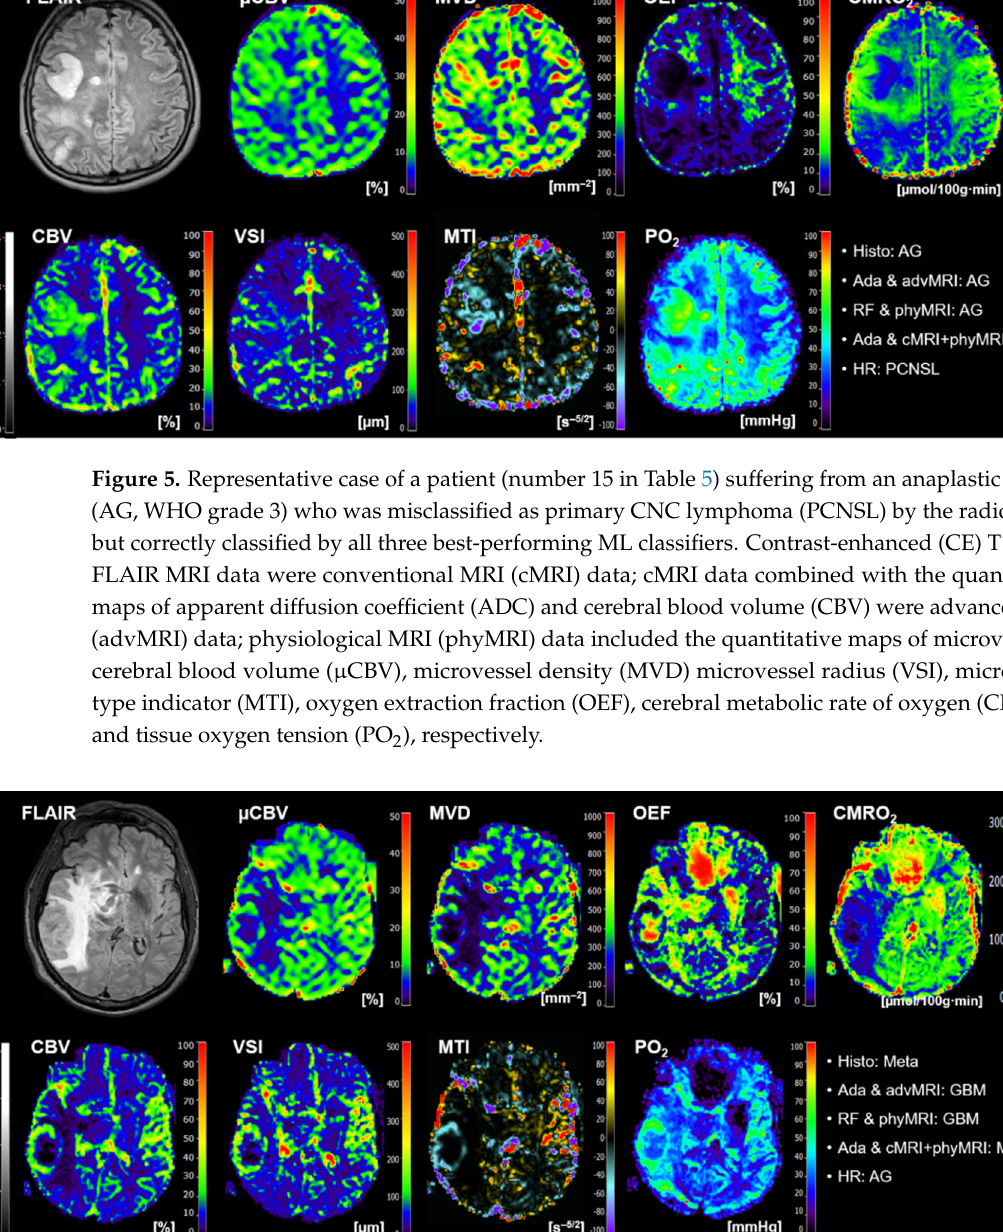
Figure 6. Representative case of a patient (number 7 in Table 5) suffering from a brain metastasis that was misclassified by the radiologists and by two of the three ML models. Contrast ‐ enhanced (CE) T1w and FLAIR MRI data were conventional MRI (cMRI) data; cMRI data combined with the